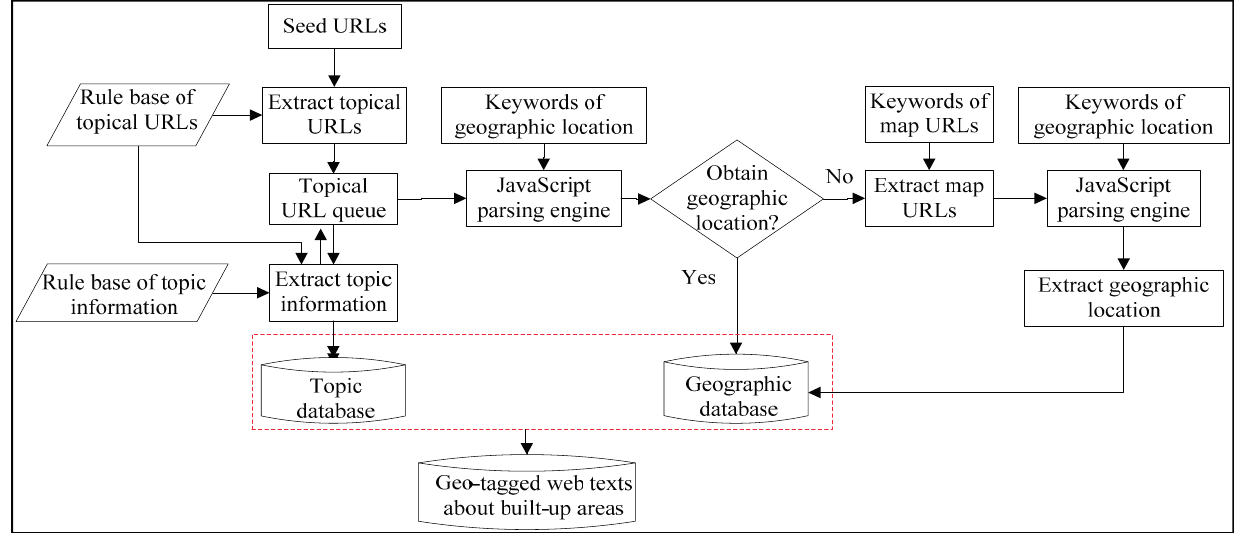
Figure 3. The framework of the proposed deep web